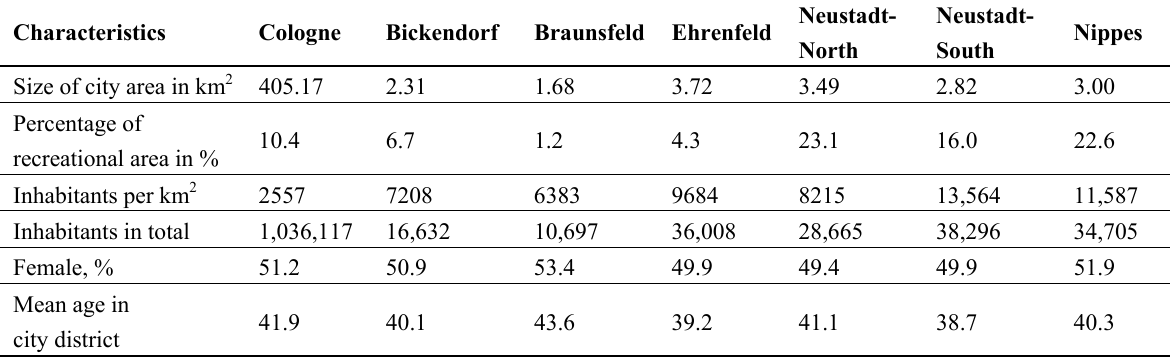
Table 1. Statistical data for Cologne and selected city districts